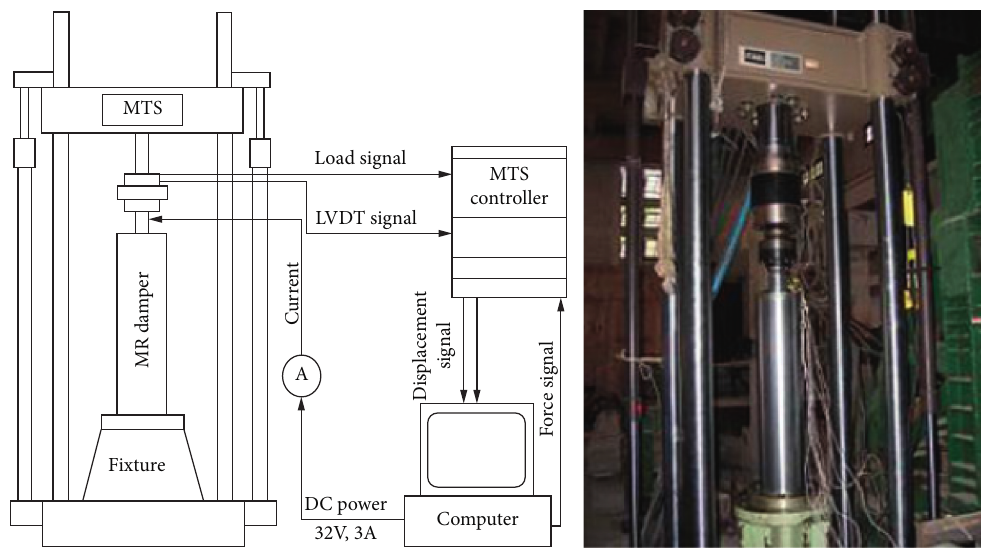
Figure 6: MR damper performance test setup [27]. Table 5: The main parameters of the MR damper.